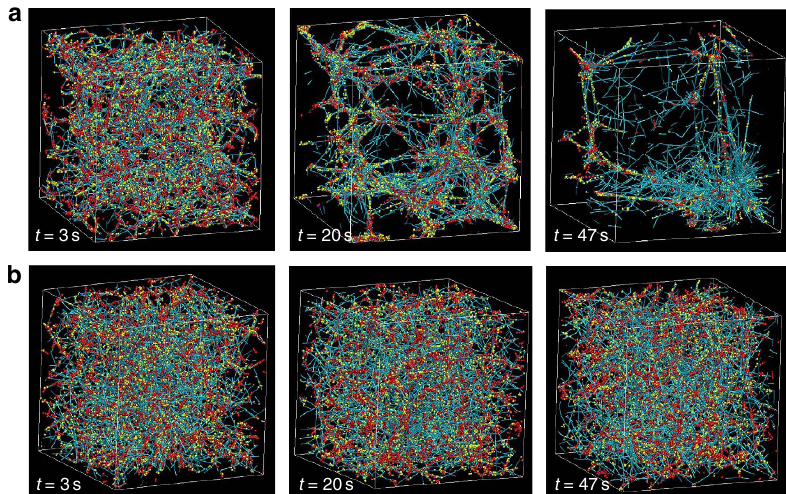
Figure 1 | Network morphologies in the aggregated and homogeneous phases. ( a ) A 3D cytoskeletal network (3 (cid:2) 3 (cid:2) 3 m m) with an actin turnover rate of 30s (cid:3) 1 with 25 m M actin, 5% ACPs (to actin) and 5% motors (to actin) at different time points. Motors start walking at t ¼ 0s, and at t ¼ 3s, the network is homogeneous. At t ¼ 20s and 47s, the network is progressively aggregating due to internal stress. ( b ) A network that has an actin turnover rate of 300s (cid:3) 1 with 25 m M actin, 5% ACPs and 5% motors stays homogeneous and can sustain the motor-generated internal stress. Similar morphological states can be observed in 2D cortical networks (Supplementary Fig. 1). Teal, yellow and red are actin filaments, ACPs and motors,